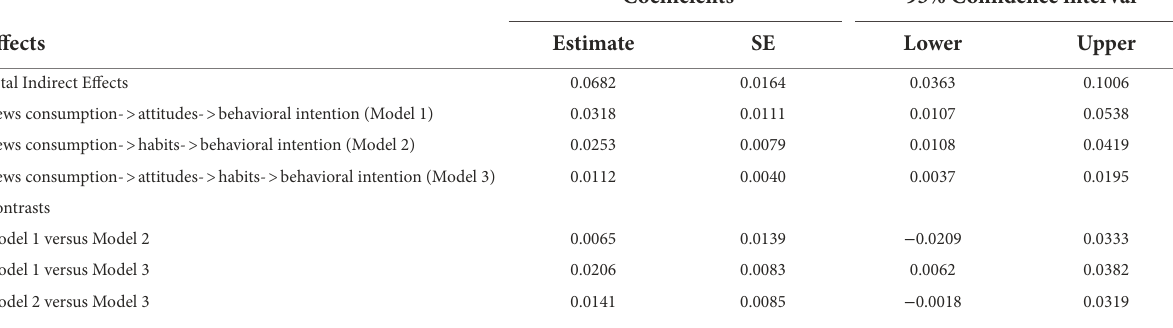
TABLE 6 Comparison of the indirect effects of news consumption on behavioral intention through attitudes and habits and its specific indirect